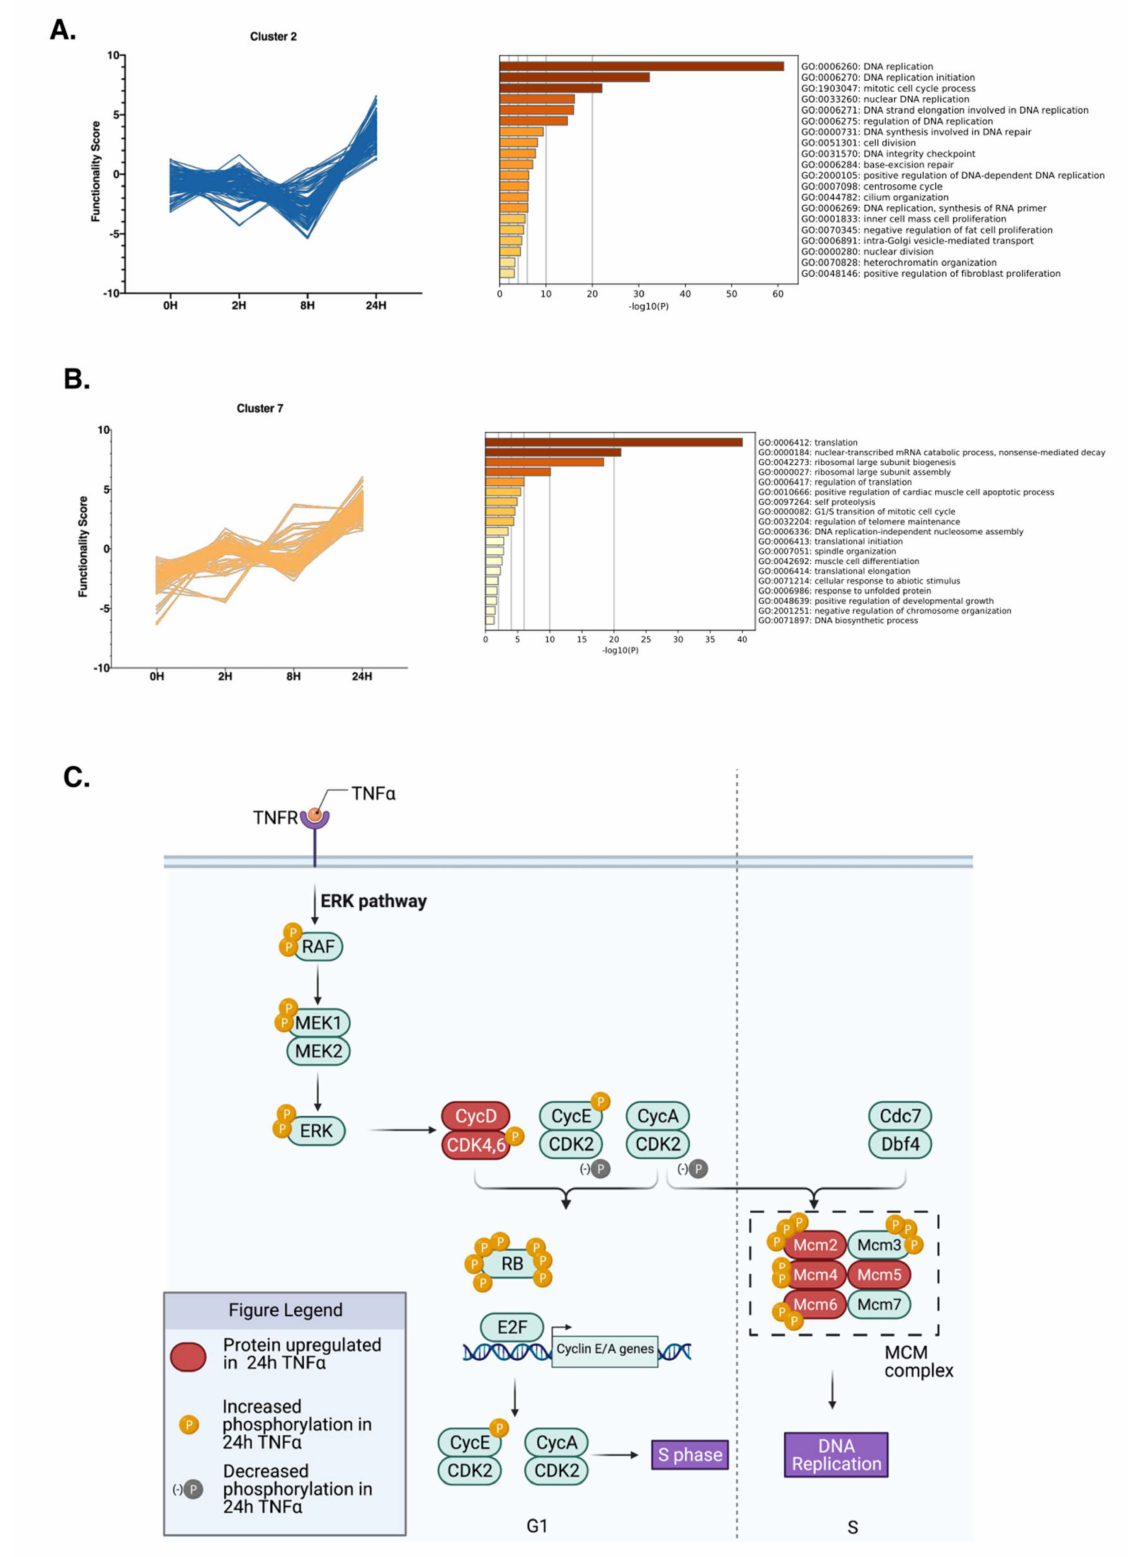
Figure 7. Clustered proteins show time-dependent regulation after TNF α treatment. ( A , B ) Proteins in clusters 2 and 7 are plotted based on their functionality score at each time point. Significantly ( p < 0.05) regulated biological processes for these proteins are shown next to the graph. ( C ) Summary of our results. TNF α treatment induces the phosphorylation of proteins involved in the MEK/ERK kinase pathway, inducing the phosphorylation of several cell cycle regulators, including Cyclin-dependent kinases and transcription factors such as the Rb